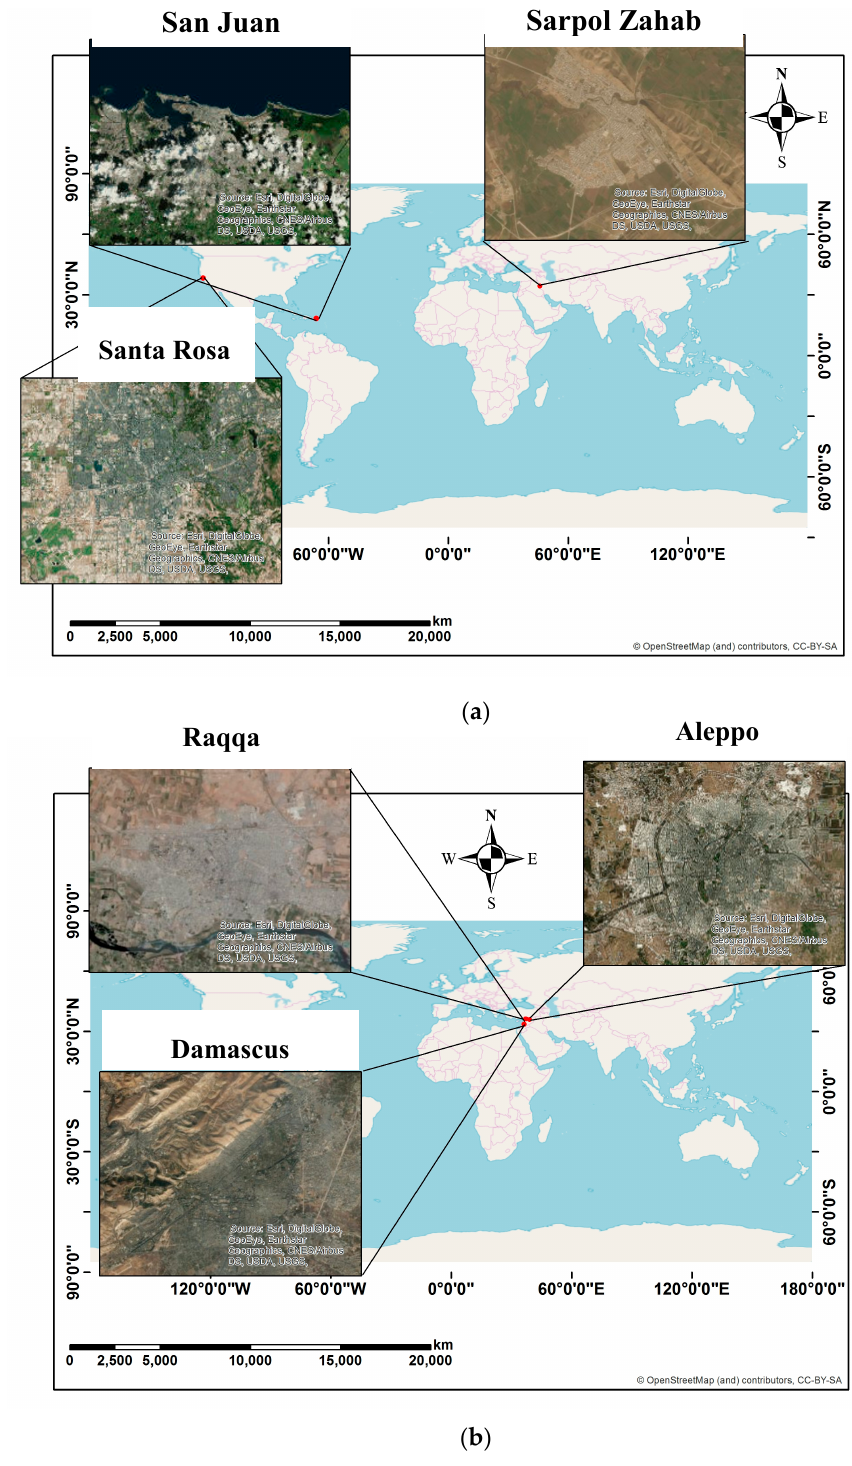
Figure 2. Study areas: ( a ) Areas affected by natural disasters; ( b ) Areas affected by anthropogenic disasters.